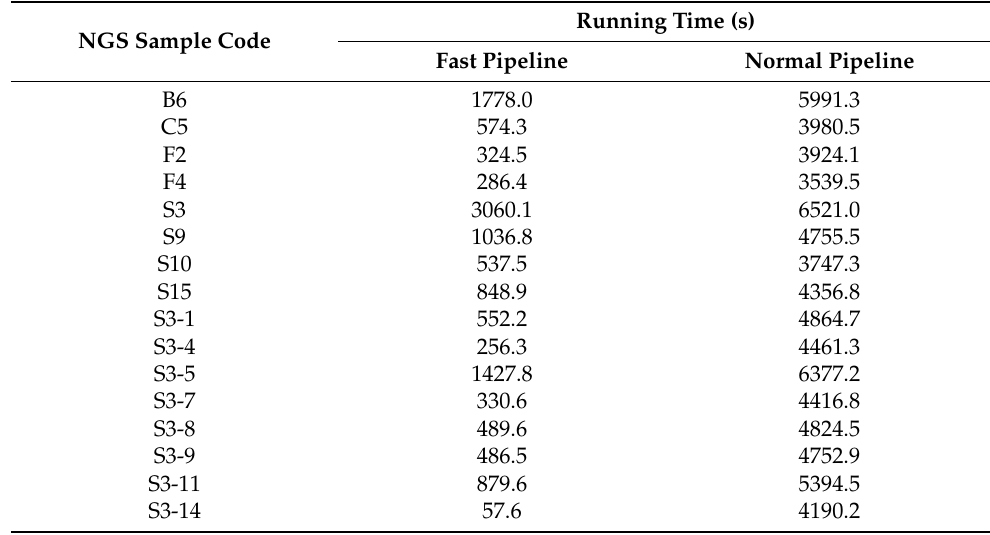
Table 15. Total time required to fully complete each pipeline in detecting nucleotide substitution and amino acids